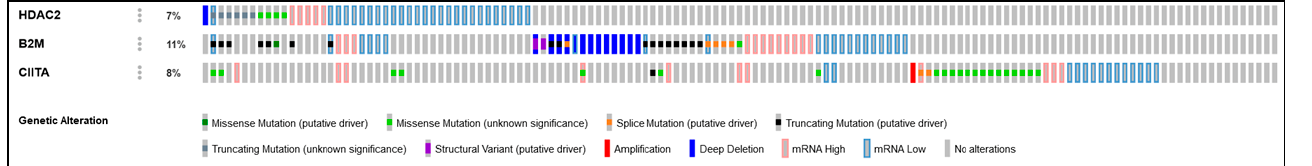
Figure 9. OncoPrint dataset showing HDAC2 , B2M , and CIITA profiles in 594 CRC patients/samples harboring alterations related to the percentage of mutations, deep deletions, mRNA expression levels, structural variants, and amplifications.